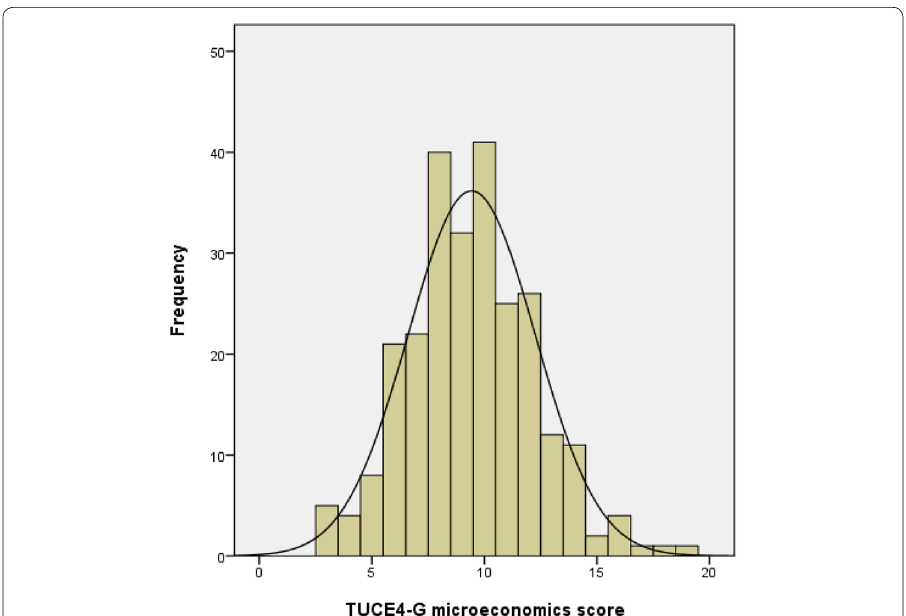
Fig. 3 Histogram of scores on TUCE4‑G items concerning